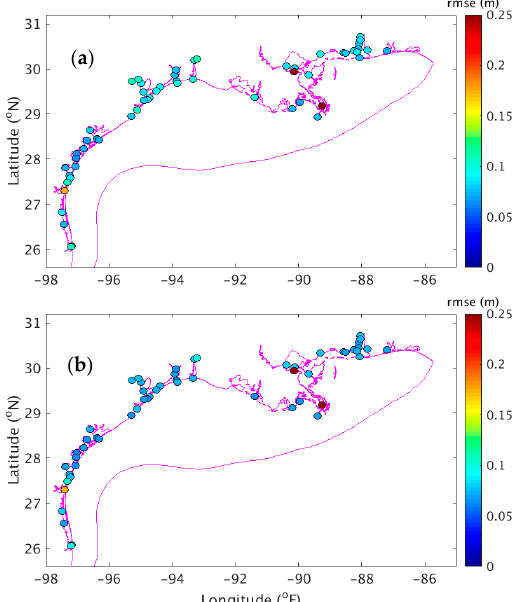
Figure 9. The RMSE of the model ( a ) total water levels and ( b ) subtidal water levels at 55 CO-OPS stations (Section 4.1).